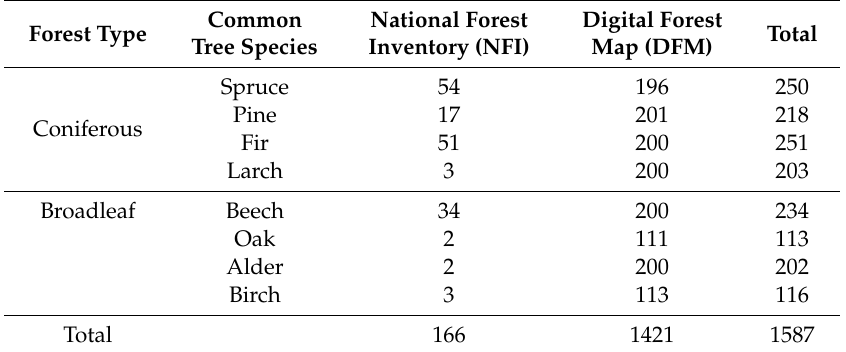
Table 1. The number of reference samples used for forest type and tree species classification. Common Forest Type Tree